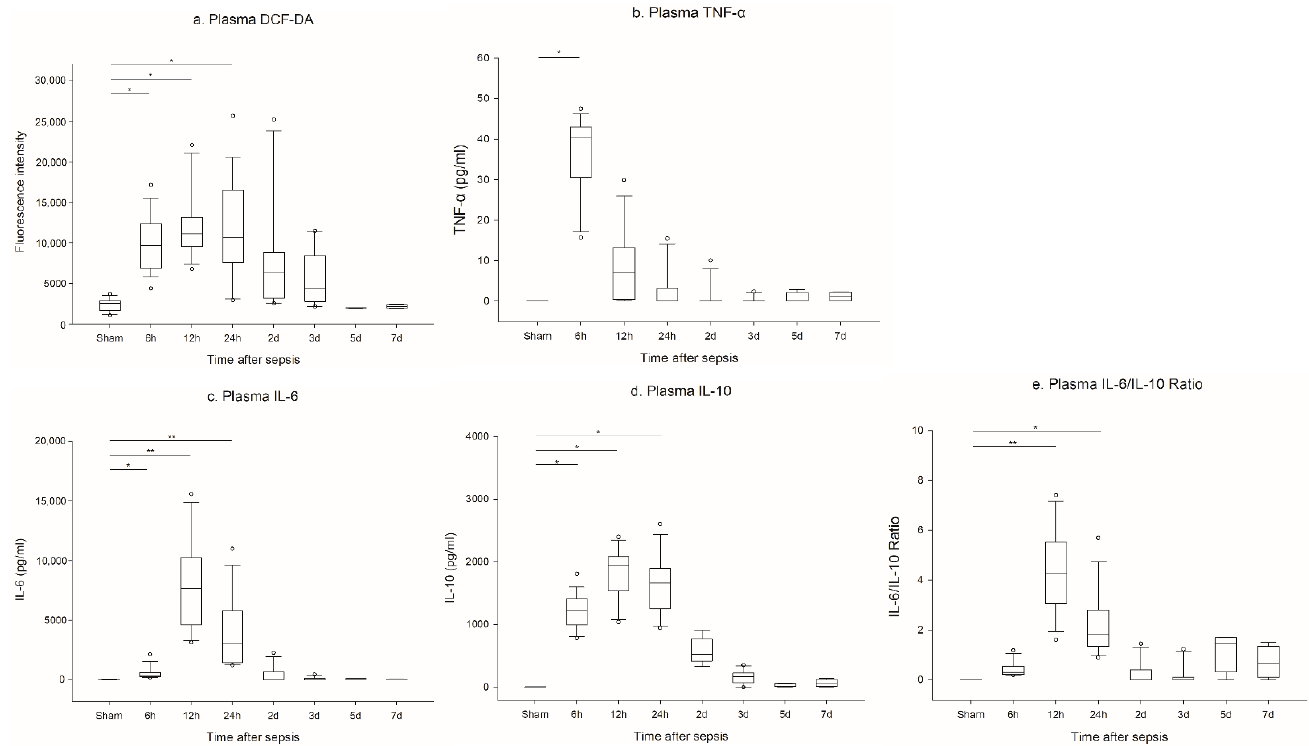
Figure 3. Serial change of plasma reactive oxygen species and cytokines: ( a ) Plasma DCF-DA (sham 2 D n = 11, 6 and 24 h n = 17, 12 h n = 12, 3 D n = 10, 5 and 7 D n = 4); ( b ) plasma TNF- α (sham n = 14, 6 h n = 17, 12 h n = 12, 24 h n = 17, 2 D n = 11, 3 D n = 10, 5 and 7 D n = 4); ( c ) plasma IL-6 (sham n = 9, 6 h n = 18, 12 h n = 12, 24 h n = 15, 2 D n = 11, 3 D n = 10, 5 and 7 D n = 4); ( d ) plasma IL-10 (sham n = 9, 6 h n = 18, 12 h n = 12, 24 h n = 16, 2 D n = 9, 3 D n = 10, 5 and 7 D n = 4); ( e ) plasma IL-6/IL-10 ratio (sham n = 3, 6 h n = 18, 12 h n = 12, 24 h n = 15, 2 D n = 11, 3 D n = 10, 5 and 7 D n = 4). ** p < 0.001 and * p < 0.05 compared with the sham group.